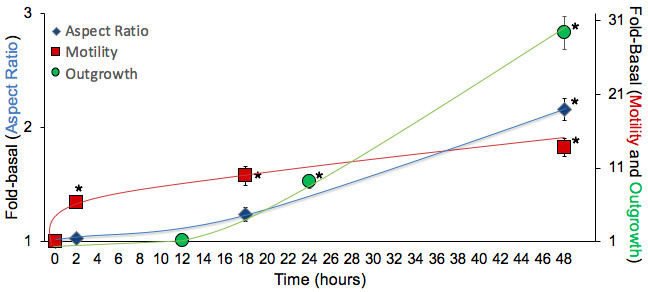
Time course studies of DRG mitochondria responses to mitofusin activation after aspiration axotomy.Studies were performed as in Figure 5. *P < 0.05 vs. basal (ANOVA). Three independent studies were performed for each endpoint; each symbol represents the mean value for all three biological replicates, each of which is the average of approximately 3 (mitochondrial motility in different neurons), 20 (outgrowth of different cell neuronal processes), or 300 (aspect ratio of individual mitochondria), technical replicates. The increase in mitochondrial motility (red) was rapid, being half-maximal after 2 hr. The increase in neuron outgrowth (green) was significant after 24 hr. Increased mitochondrial aspect ratio (blue), reflecting the morphological consequences of enhanced fusion, was only significant after 48 hr.